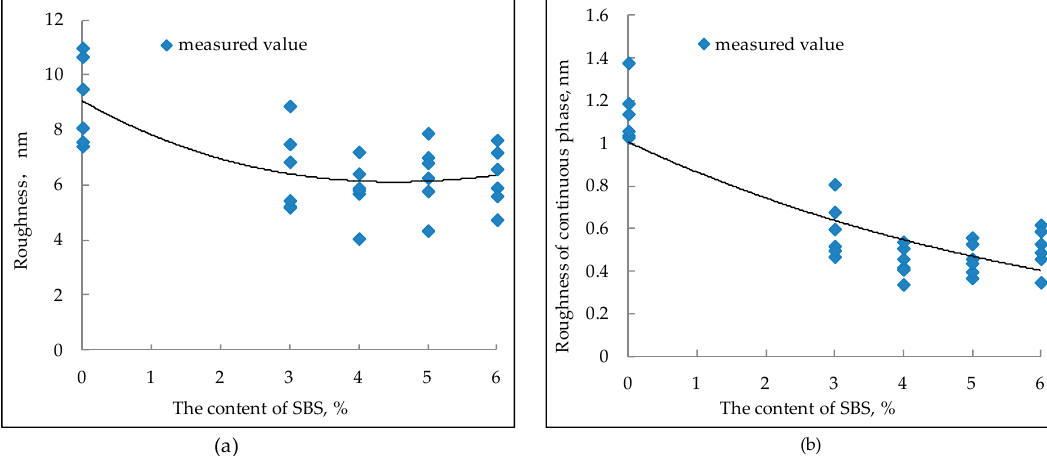
Figure 8. Relationship between roughness and the content of SBS modifier (( a ) the roughness of the whole image; ( b ) the roughness of continuous phase).